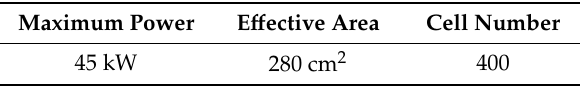
Table 1. Parameters of the test fuel cell stack.